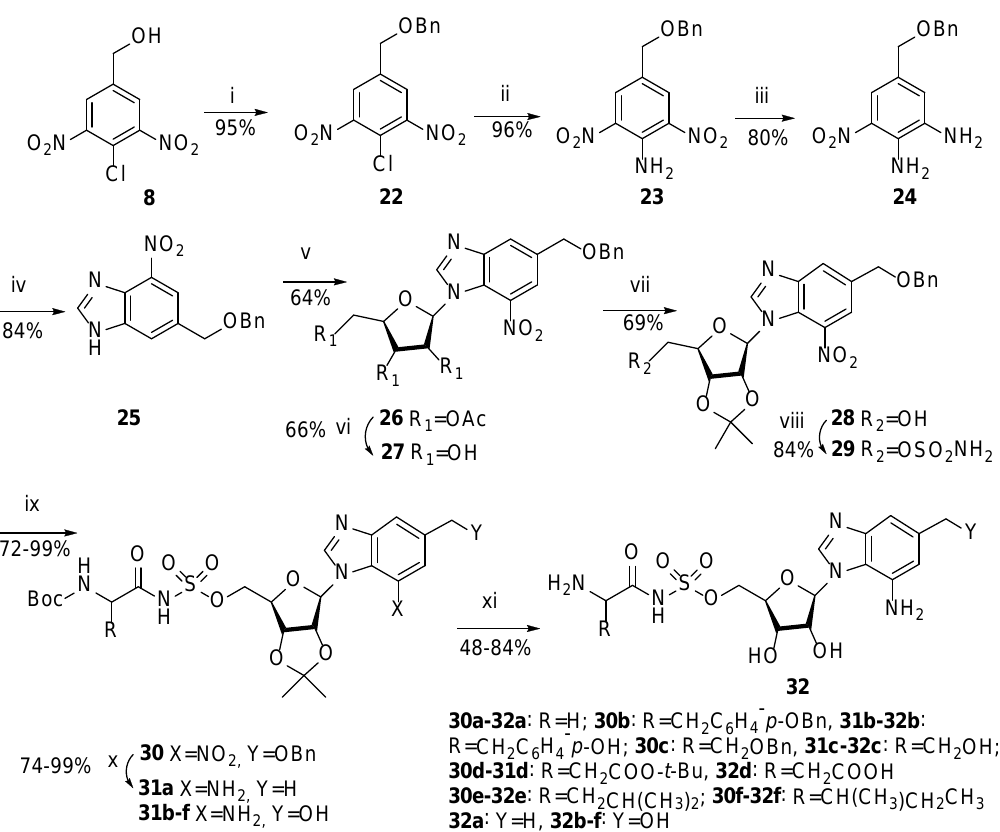
Figure 3. Decisive correlations with C5 on the N7-linked base in compound 29 are boxed in the HMBC spectrum. Labels correspond to assignments in proton and carbon dimensions.